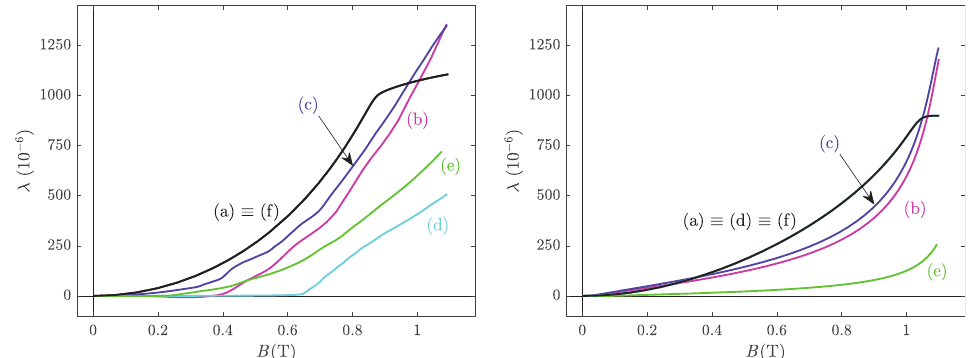
Figure 7. Predicted longitudinal anhysteretic magnetostriction strain under stress-free (a); 1D compression (b); equibiaxial compression (c); pure shear at 0 ◦ with respect to the magnetisation (d); pure shear at 45 ◦ with respect to the magnetisation (e); and hydrostatic pressure (f). The stress amplitude σ is set at − 40